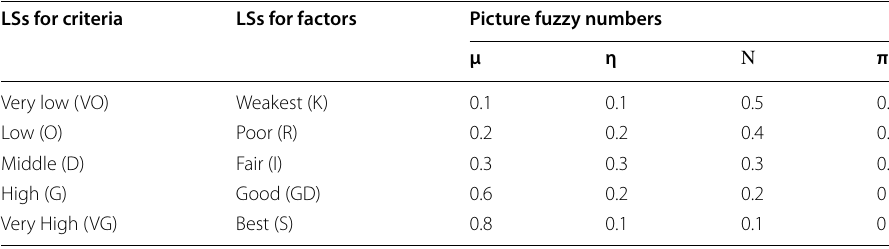
Table 6 LSs and picture fuzzy numbers for evaluation LSs for criteria